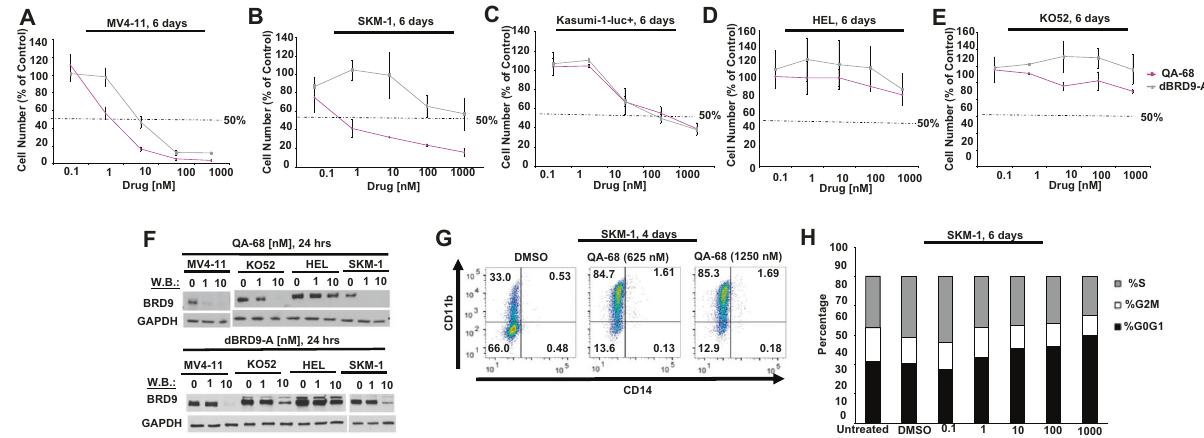
Fig. 2 BRD9 degrader treatment leads to inhibition of AML cell line proliferation. A – E Proliferation assays: AML cell lines treated with QA- 68 or dBRD9-A. 6-day assay. Proliferation studies shown are representative of independent studies performed at least twice for which similar results were observed. F Effects of QA-68 (upper panel) and dBRD9-A (lower panel) on BRD9 expression in QA-68-sensitive and – insensitive AML cell lines. 24-hour assay. G Effects of QA-68 on SKM-1 cell differentiation. 4-day assay. H Effects of QA-68 on SKM-1 cell cycle progression. 6-day